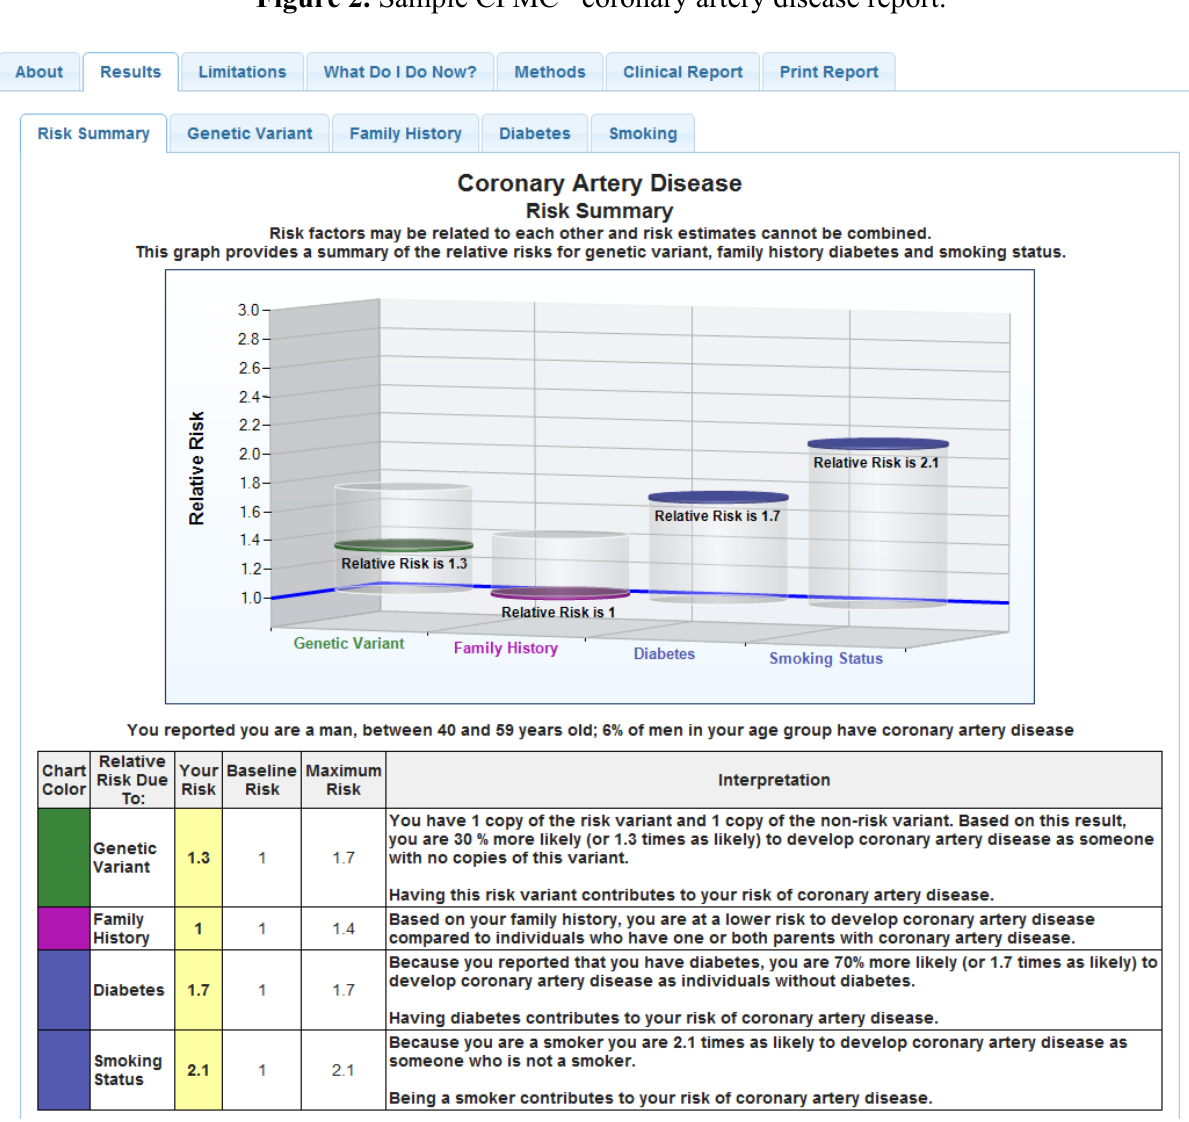
Figure 2. Sample CPMC ® coronary artery disease